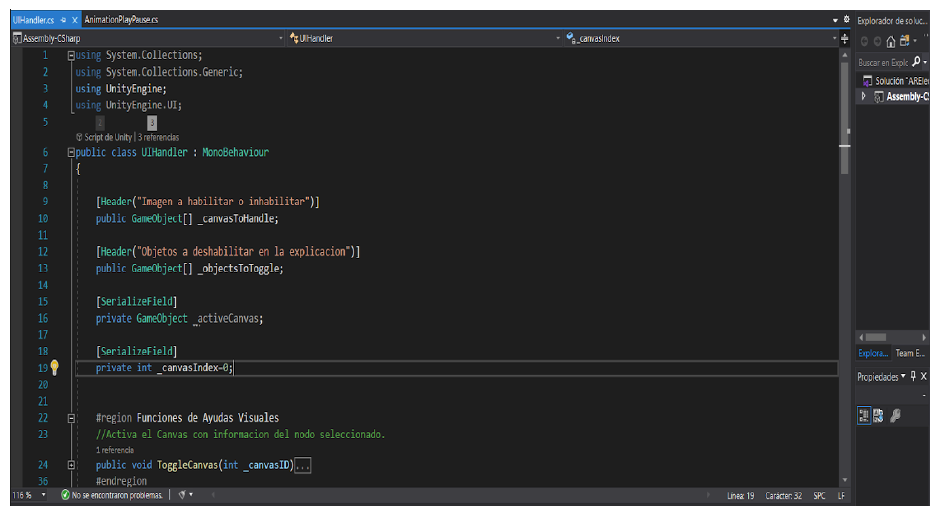
Figure 5. Script UIHandler to activate/deactivate visual aid or scene changes.